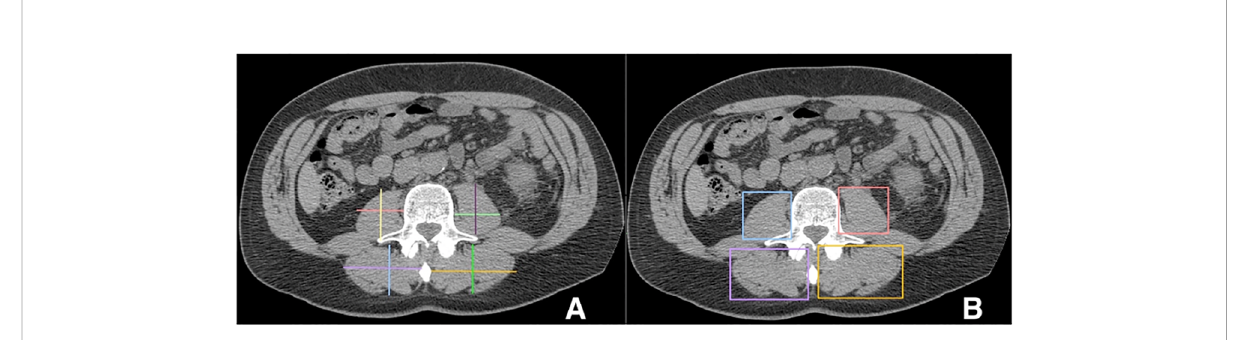
FIGURE 1 Linear measurements of the Lumbar Psoas and Paraspinal Musculature Using the Digital Ruler Tool (A) and the Box Measurement Tool (B)